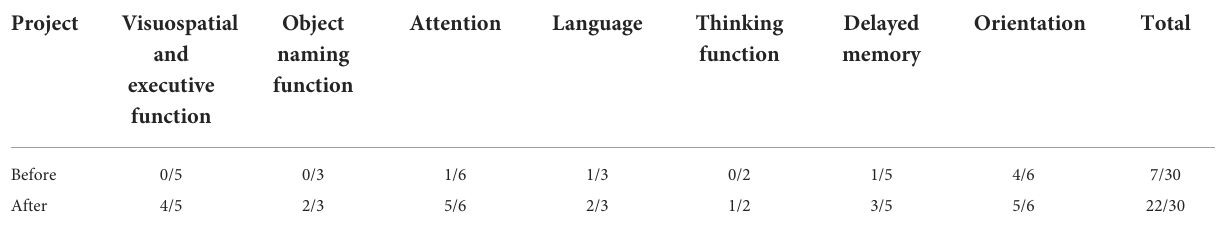
TABLE 1 The assessment results of MoCA.